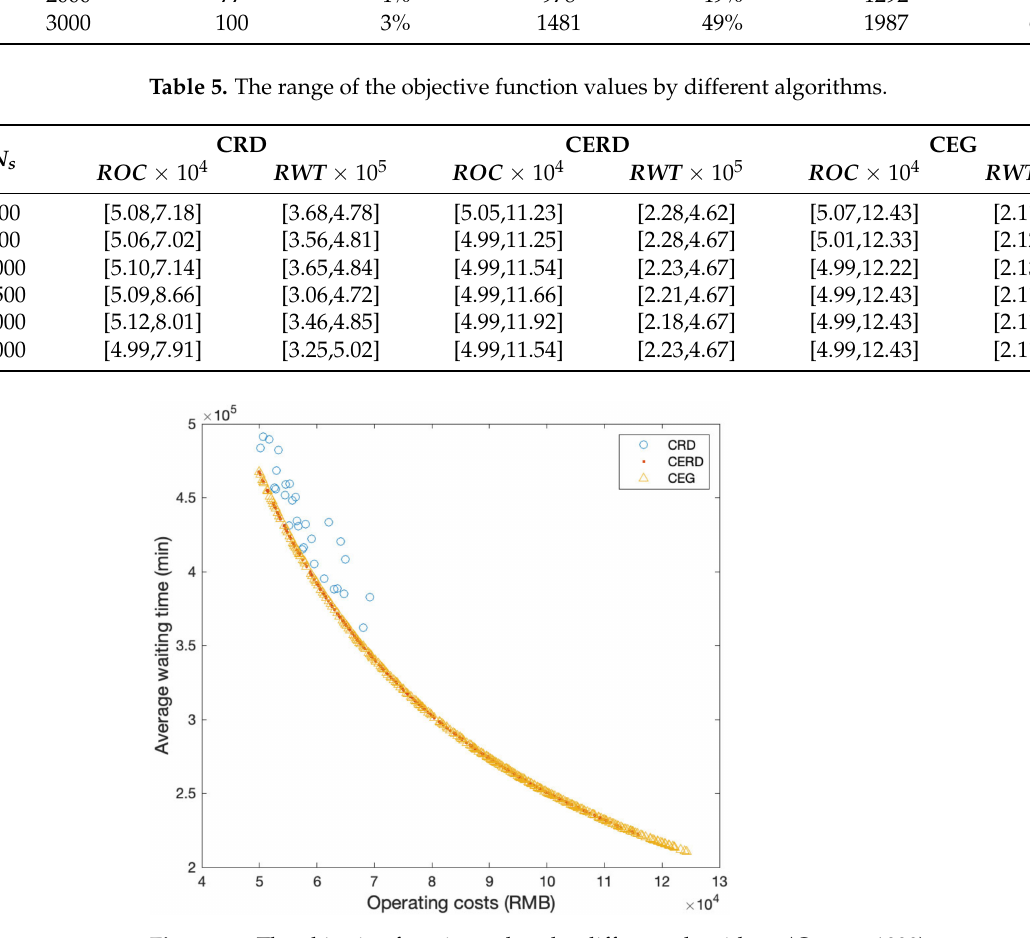
Figure 17. The objective function values by different algorithms ( G max =